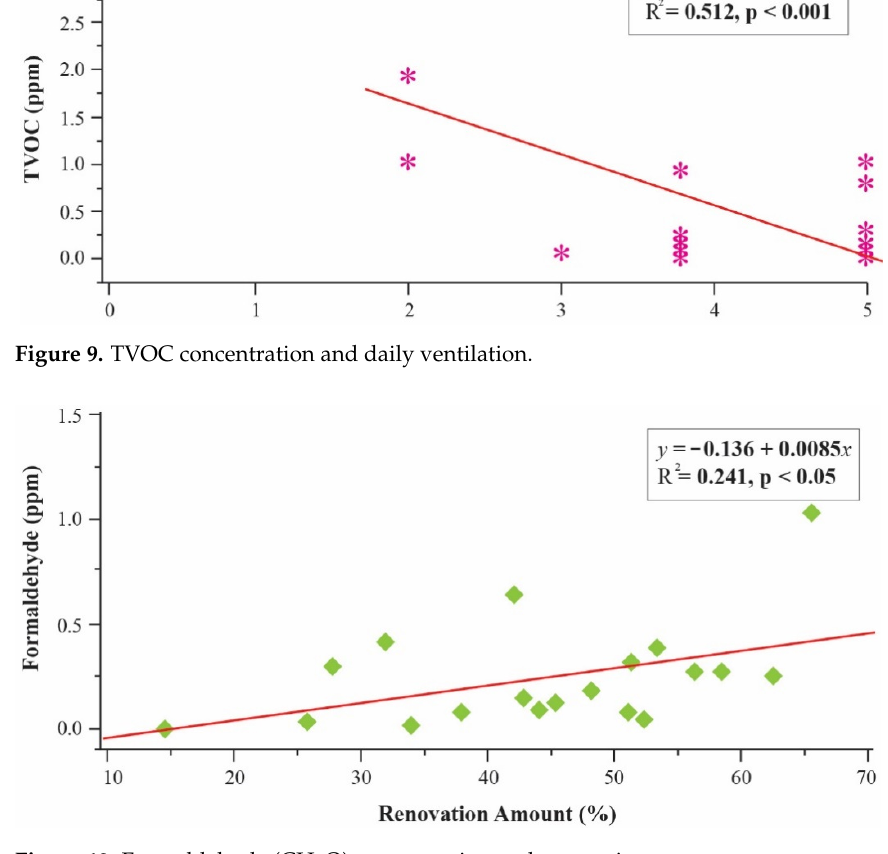
Figure 10. Formaldehyde (CH 2 O) concentration and renovation amount.